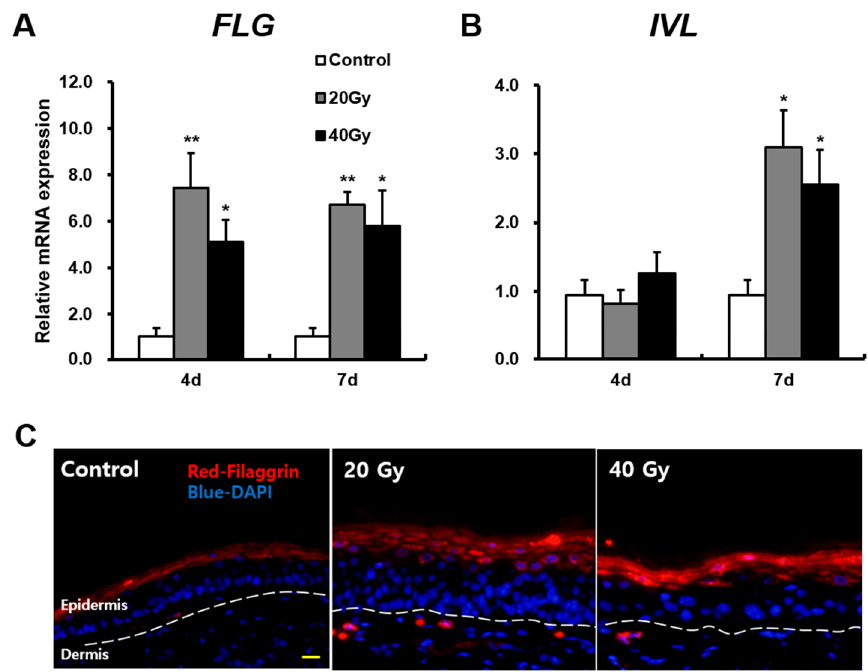
Figure 2. Increased fundamental proteins of the skin barrier in the latent stage on irradiated skin. mRNA levels of ( A ) filaggrin (FLG), ( B ) involucrin (IVL) in the skin of 0 (Control), 20, and 40 Gy irradiated mice at 4 and 7 days. ( C ) Immunofluorescence stain of FLG in the irradiated skin of 20 and 40 Gy groups at 7 days. Scale bar = 20 μ m. Data are presented as the mean ± standard error of the mean. n = 5 mice for each group. * p < 0.05 and ** p < 0.01 compared with the control group.